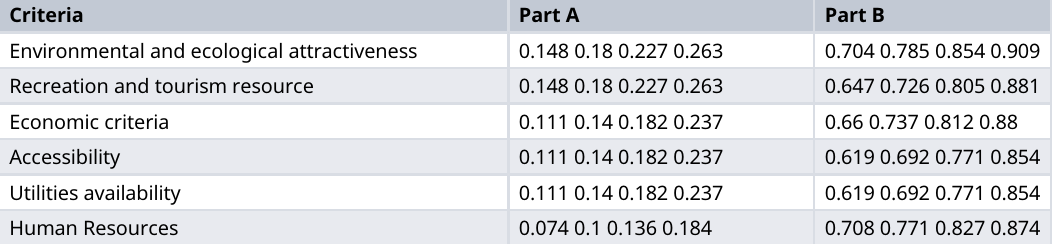
Table 7. Z-number based weights of